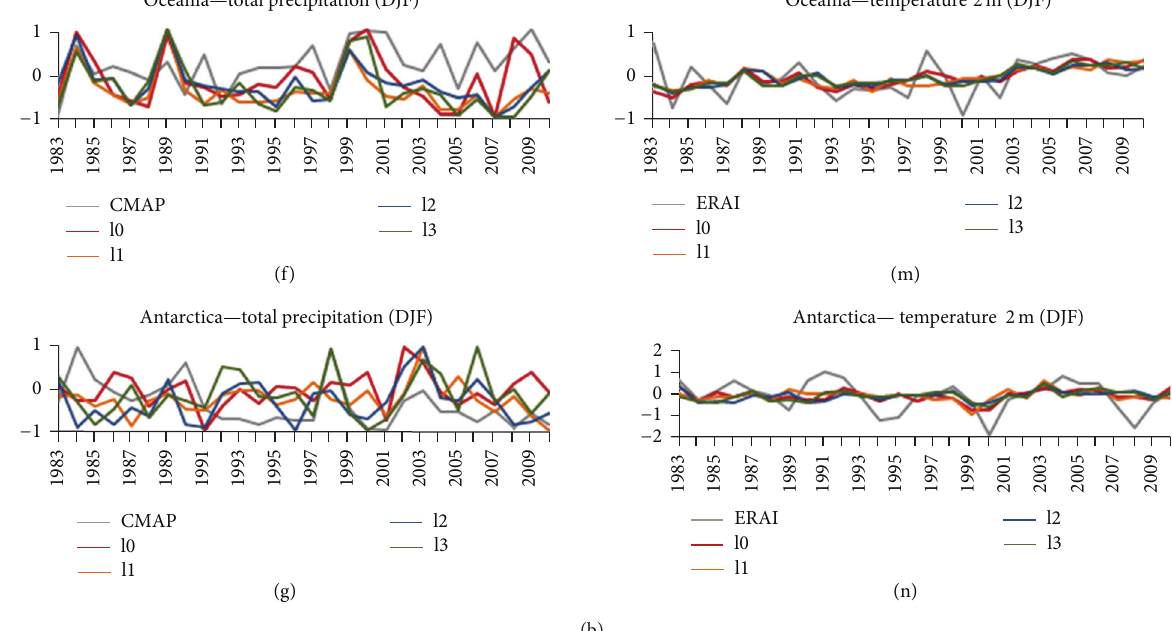
Figure 1: Interannual variability of anomaly hindcasts of CFSv2 at lead 0 (red), 1 (orange), 2 (blue), and 3 (green) for DJF season from 1983 to 2010. The corresponding dataset in gray are on the left column the total precipitation from CMAP; on the right column the temperature at 2 m from